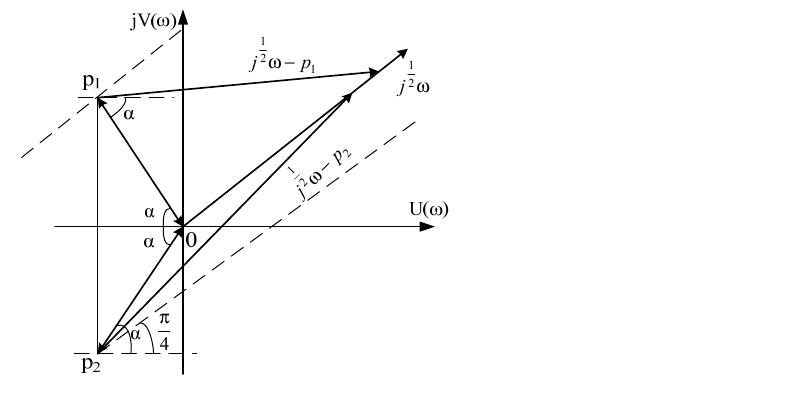
Figure 3. Vector displacement for the first two complex-conjugate roots for the case when 𝜔 𝜖 (0, ∞) .